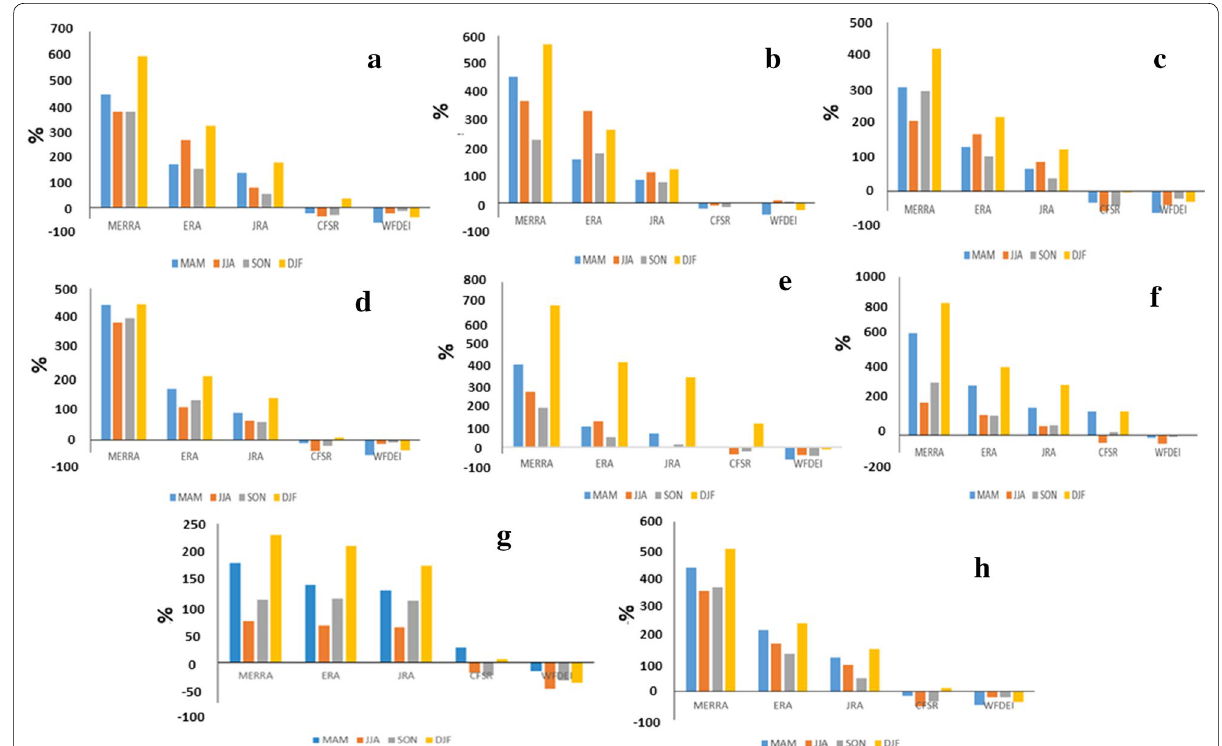
Fig.16 Monthly bias (%) of different rainfall products compared to raingauge data in four season Winter (December-February), Summer (March– May), Monsoon (June–August) and post-Monsoon (September–November) at different stations of the Beas river basin:( a ) Banjar ( b ) Bhuntar ( c ) Janjehal ( d ) Larji ( e ) Manali ( f ) Pandoh ( g ) Pong and ( h )